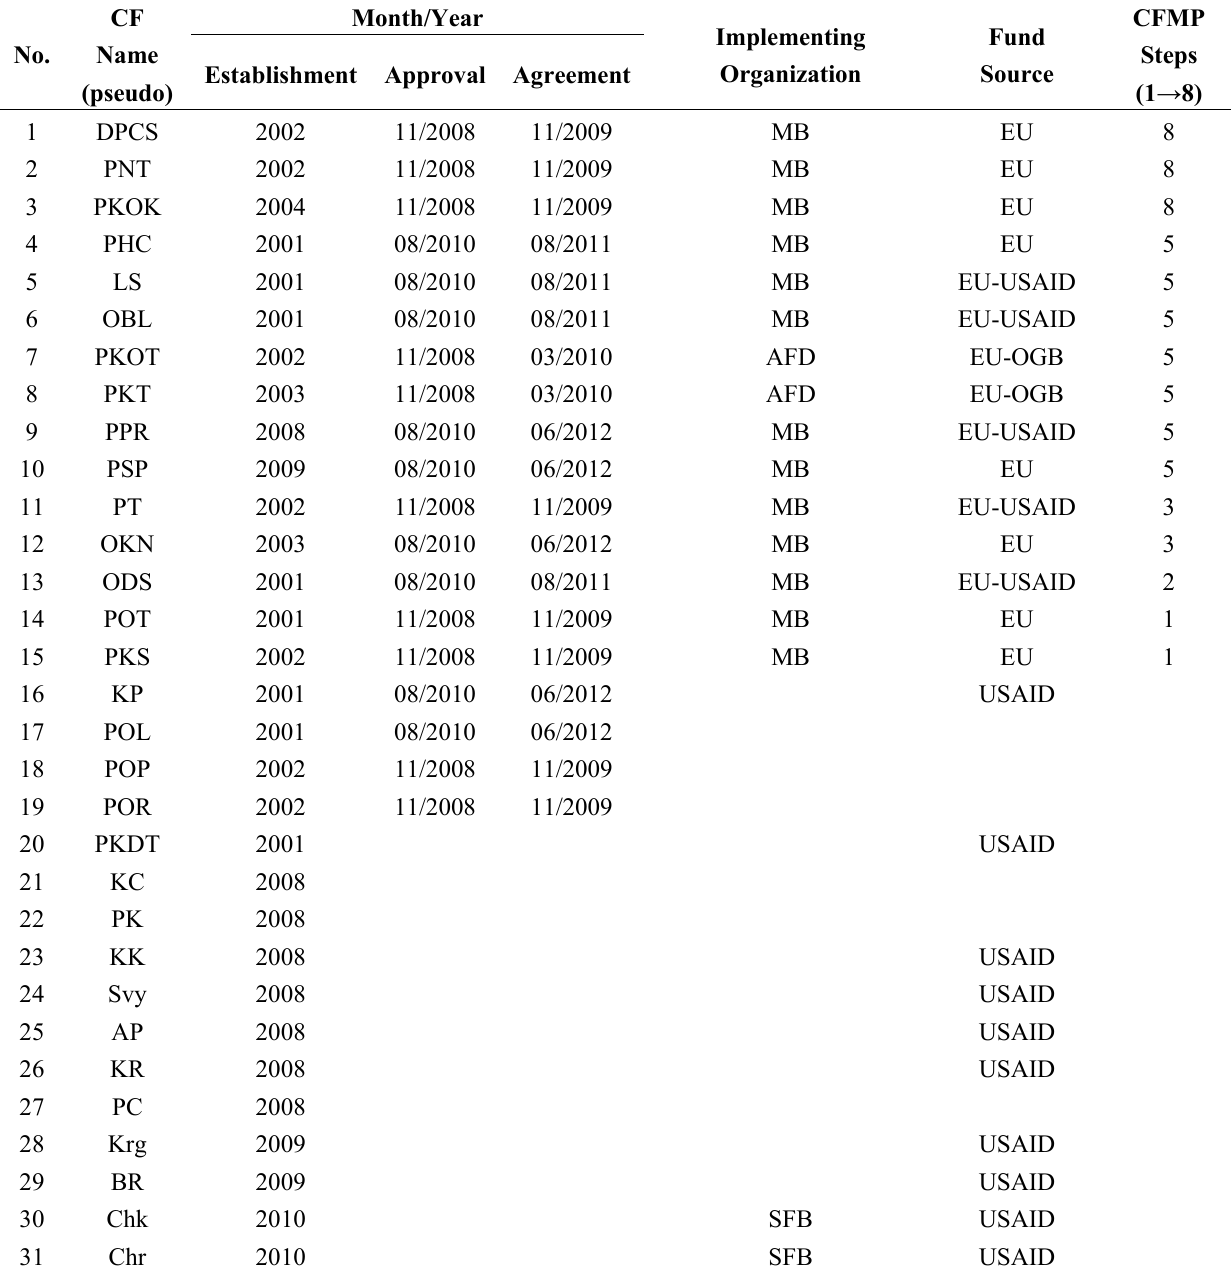
Table 2. Details of the community forestry (CF) sites in Sandan District (September